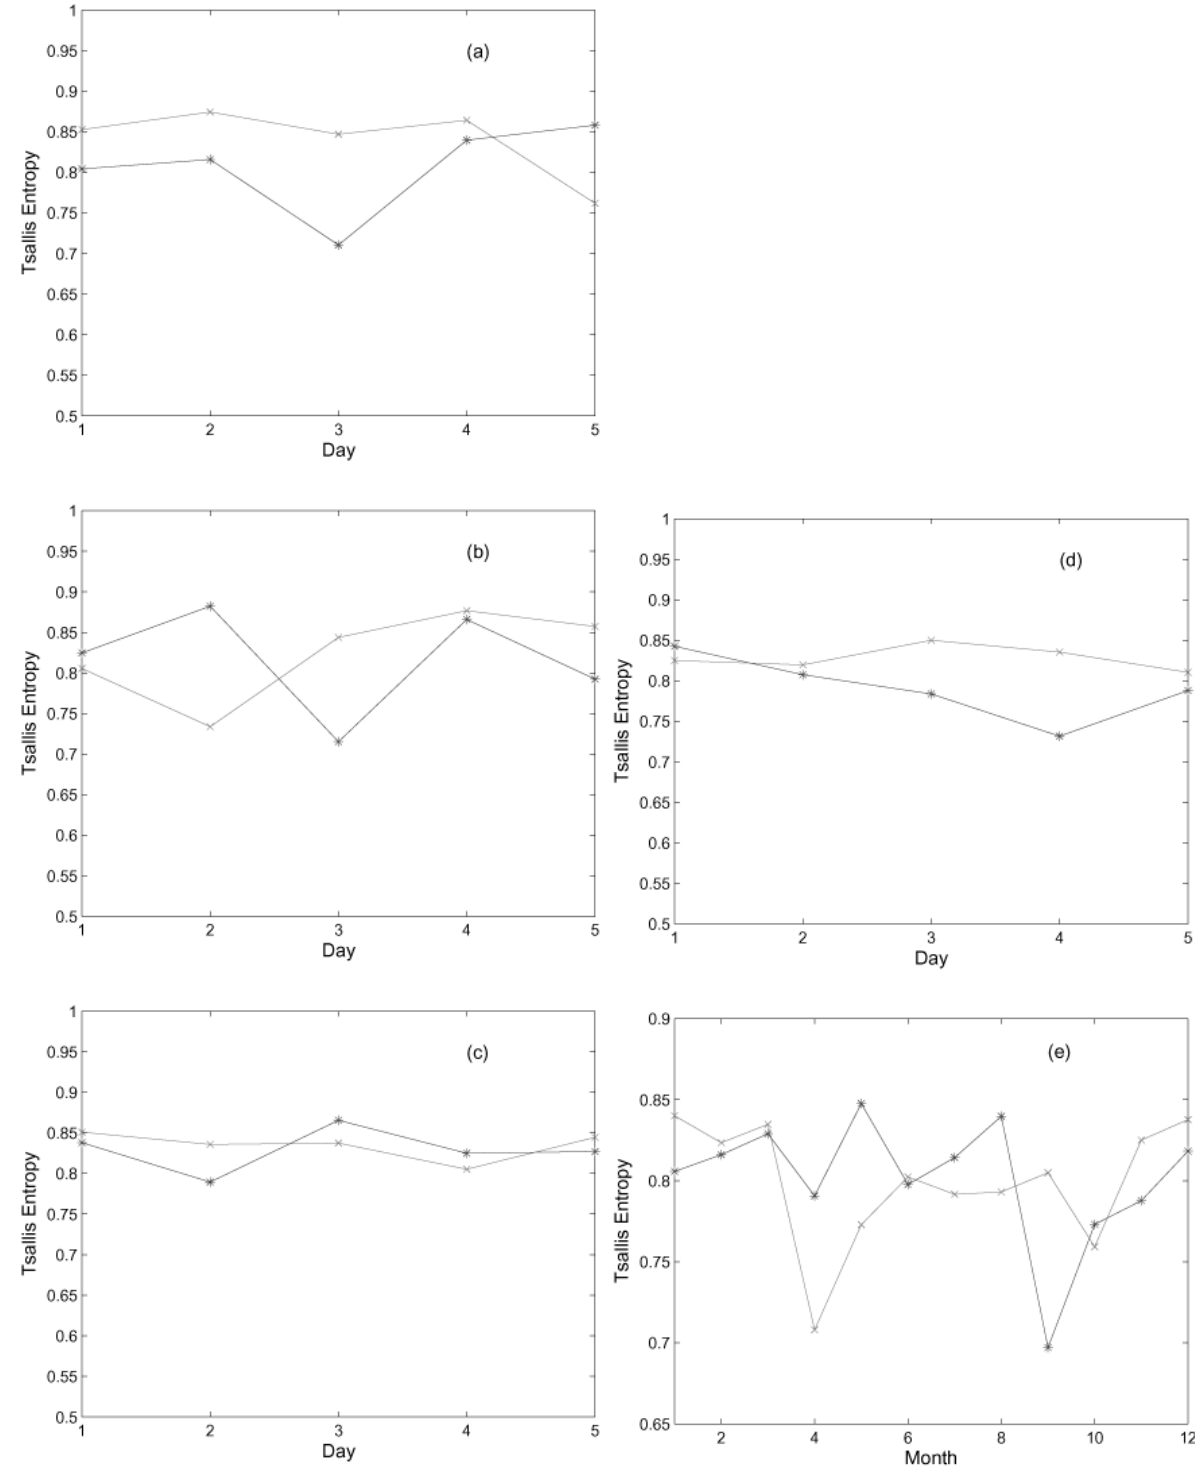
Fig. 9. Tsallis entropy for the five quietest days (red) and the five most disturbed days (blue) for (a) January, (b) February, (c) March, and (d) April. (e) Monthly mean values of Tsallis entropy for the entire year at Birnin